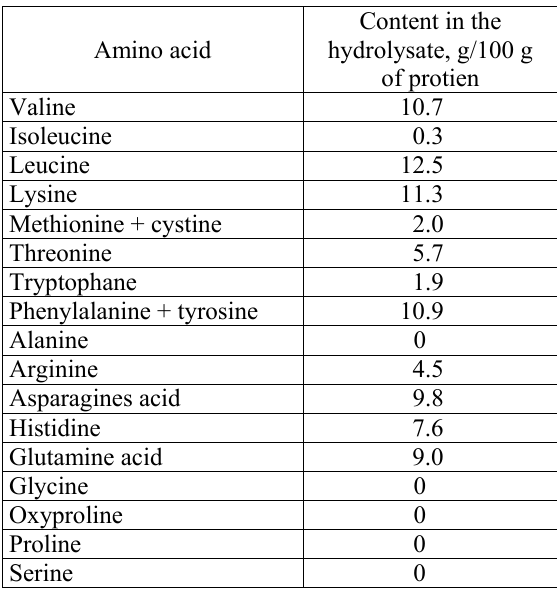
Table 2. Amino-acid composition of dried hydrolysate